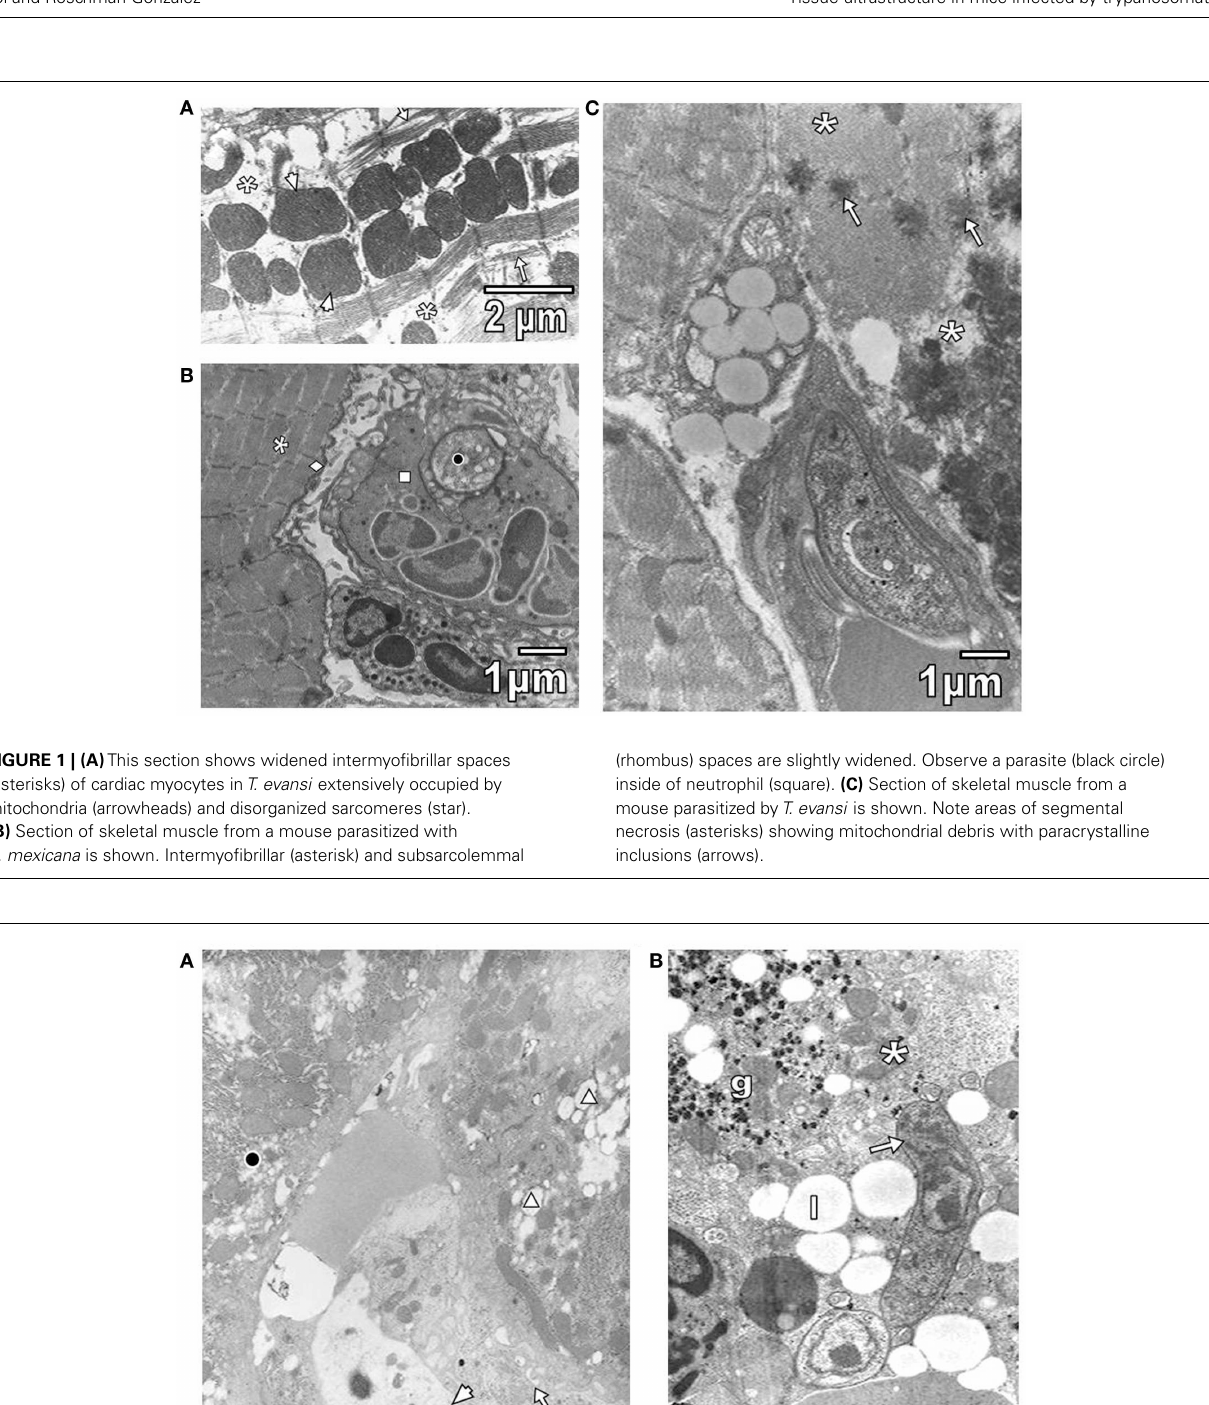
widened sinusoid endothelial cells with few pinocytic vesicles (arrowheads). (B) Sinusoid lumen showing T. evansi parasite (arrow) and hepatocyte debris, including glycogen particles (g), mitochondria (asterisk), and lipid droplets